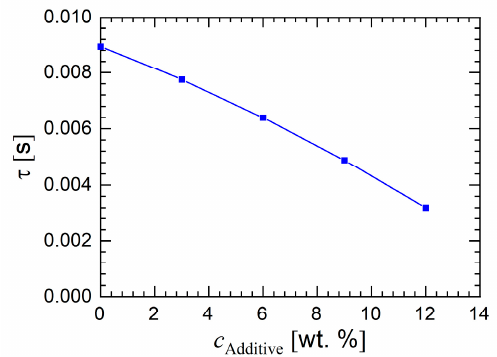
Figure 7. Average relaxation time of the additive solutions as a function of additive concentration.